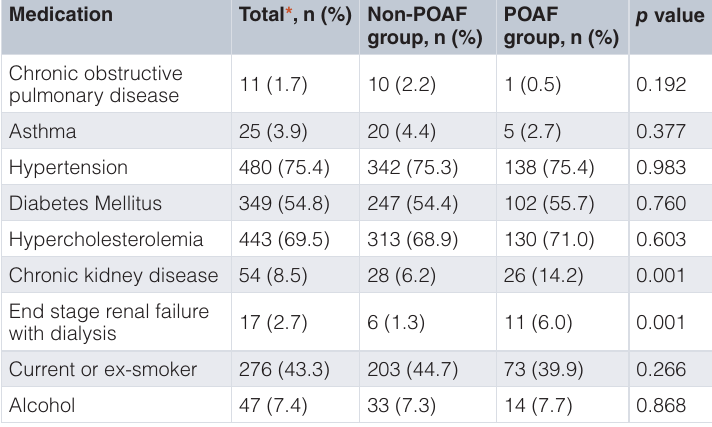
Table 4. Association between post-operative atrial fibrillation (POAF) and underlying medical conditions on admission. Medication